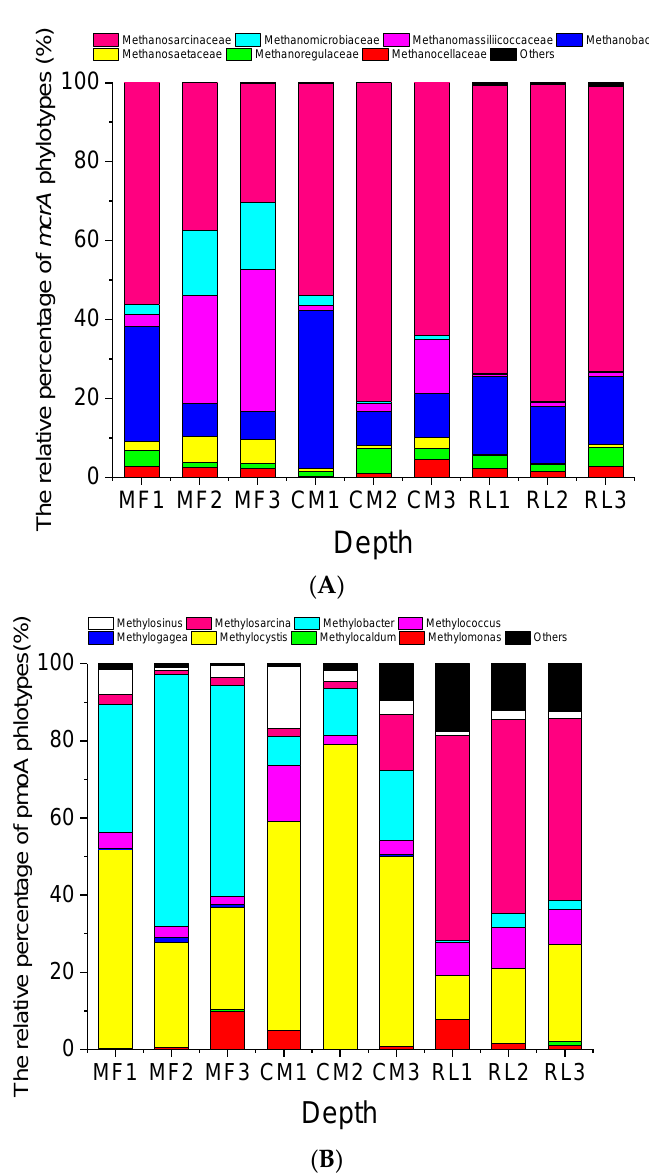
Figure 4. The relative percentage of methanogen ( A ) and methanotroph ( B ) phylotypes across three sites and soil depths in the Dongting floodplain. Site abbreviations: MF: mudflat, CM: Carex meadow, RL: reed land. 1, 2, and 3 represent the three depths: 0–10 cm, 10–20 cm, and 20–30 cm, respectively.